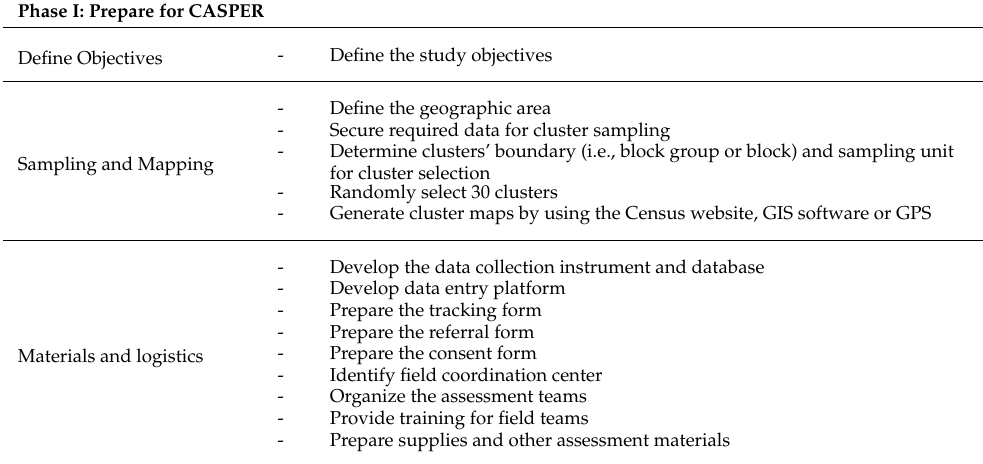
Table 1. Summary of Community Assessment for Public Health Emergency Response (CASPER)